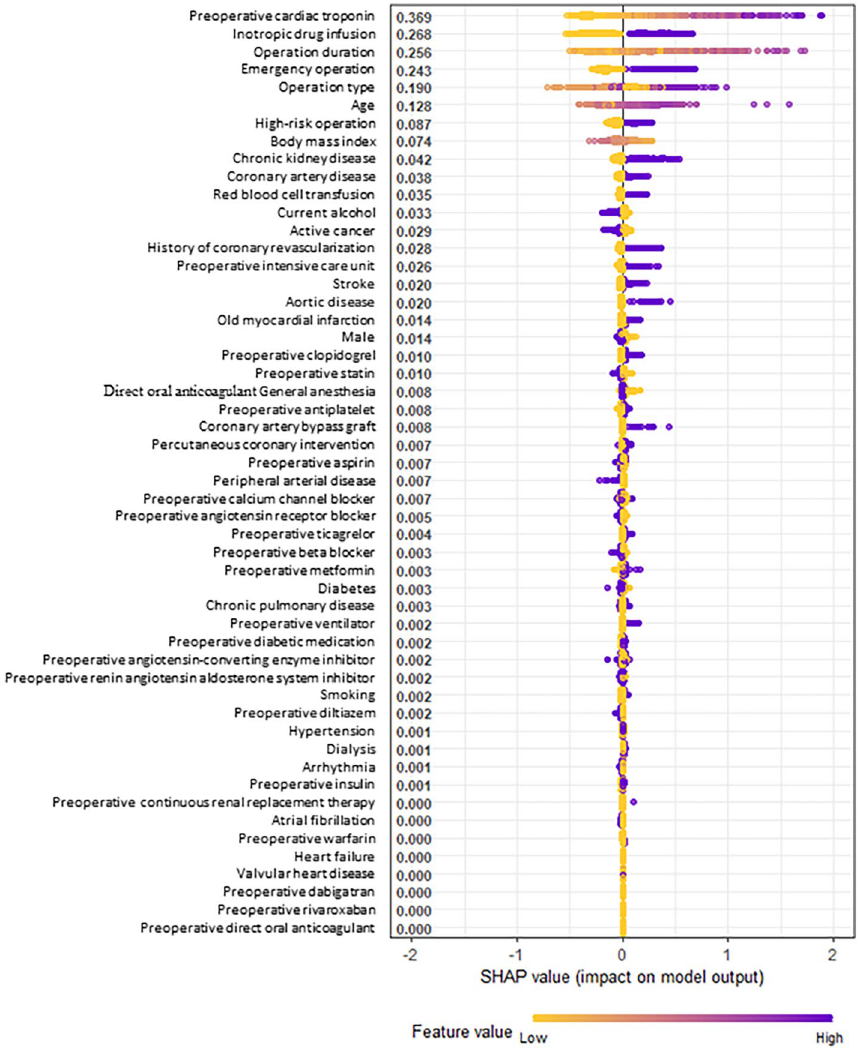
Figure 2. SHapley additive exPlanations (SHAP) summary plot representing the results of the extreme gradient boosting (XGB) algorithm of machine learning techniques.